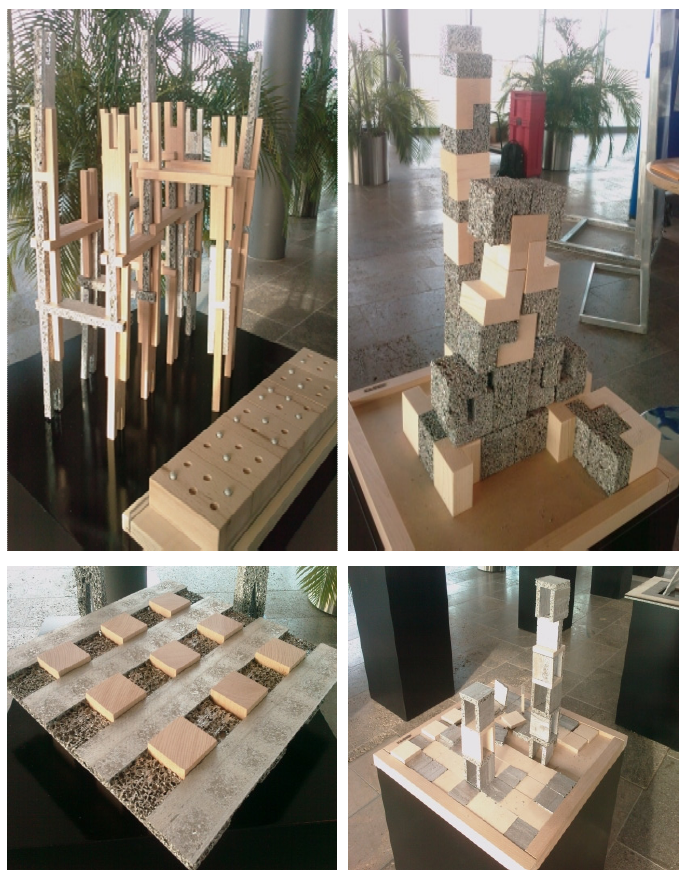
Figure 21. Artistic compositions of the designer Gerd Kaden created from wood and metallic foams.